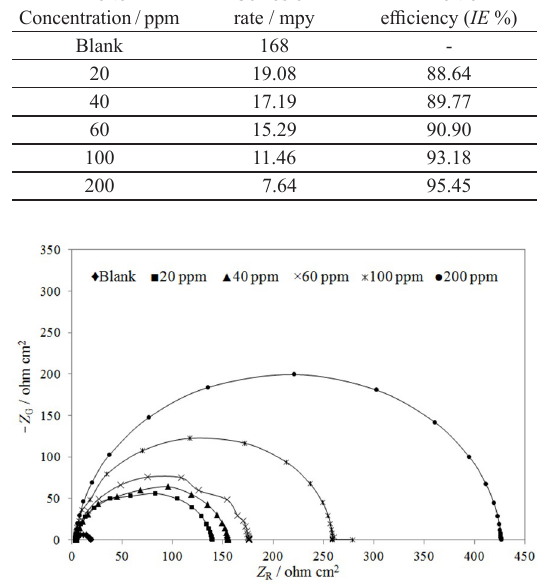
Table 1. Inhibition efficiency from weight loss measurement for mild steel in 1M HCl solutions in the presence and absence of inhibitor. Inhibitor Concentration /